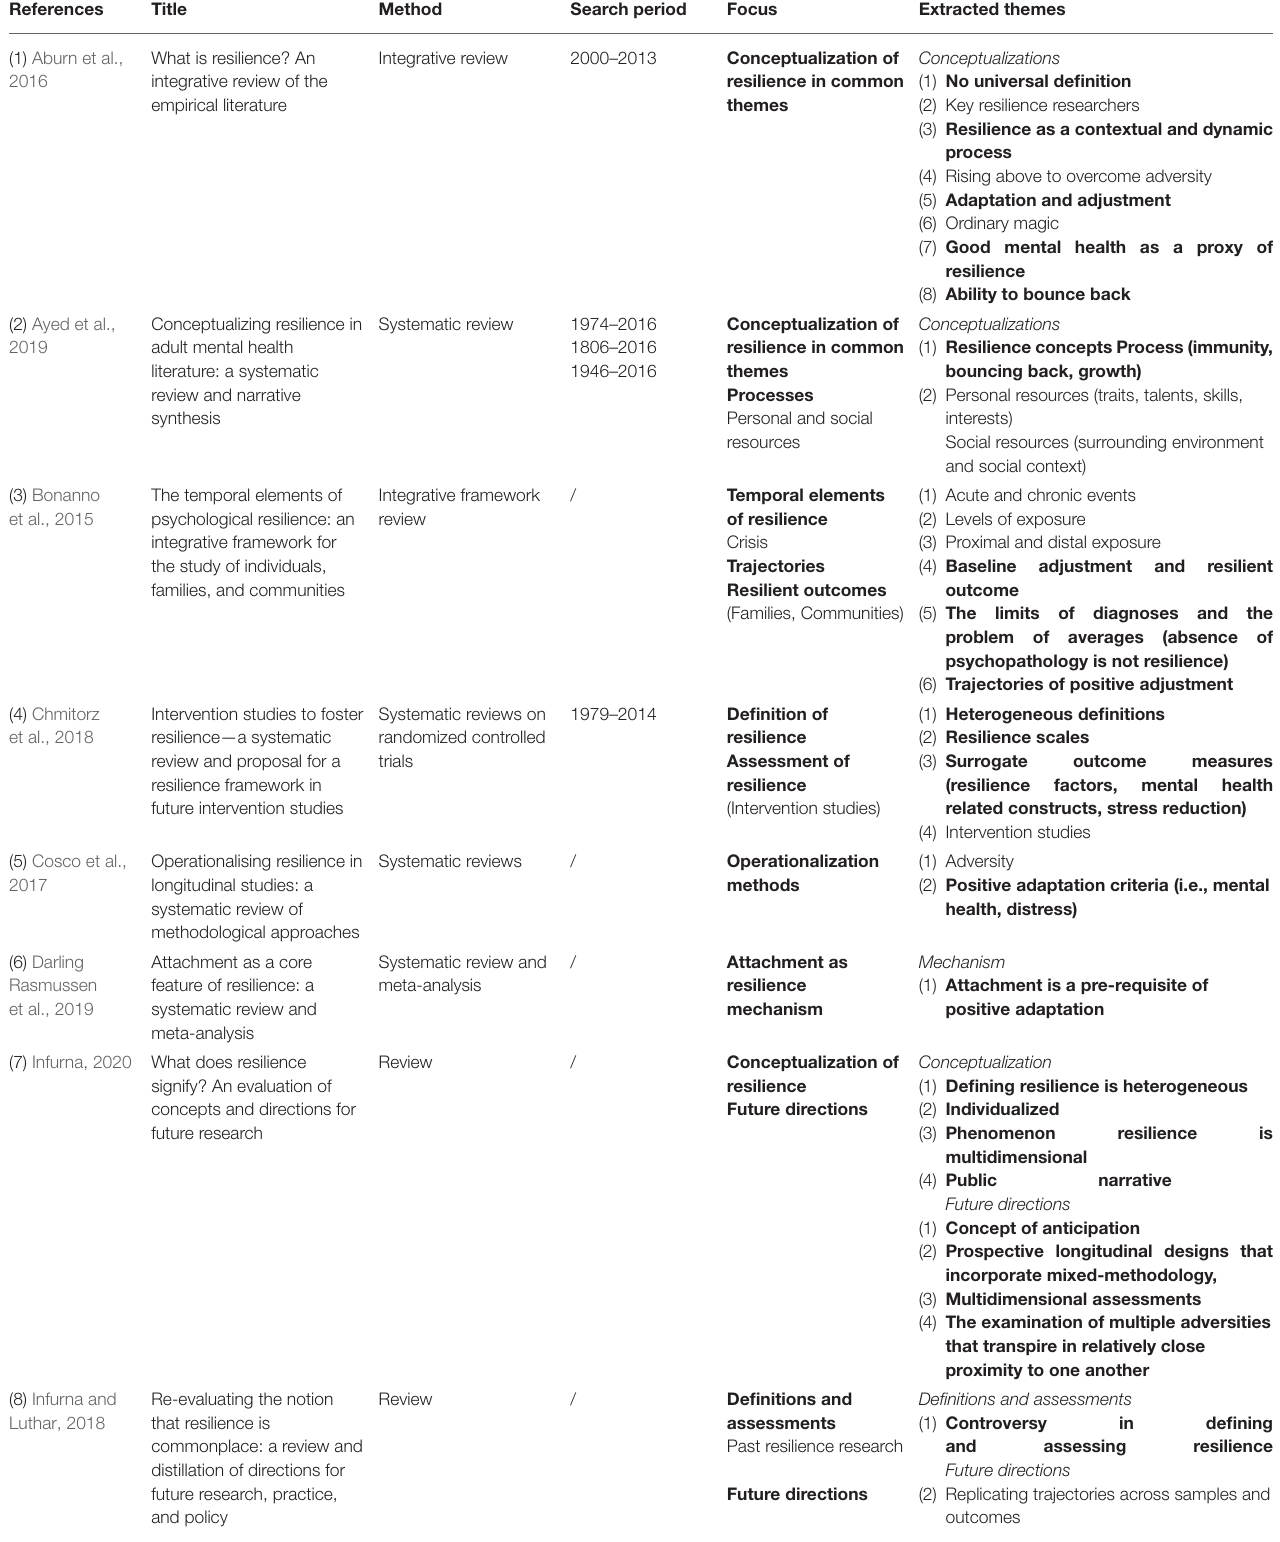
TABLE 2 | Characteristics of the included reviews and extracted